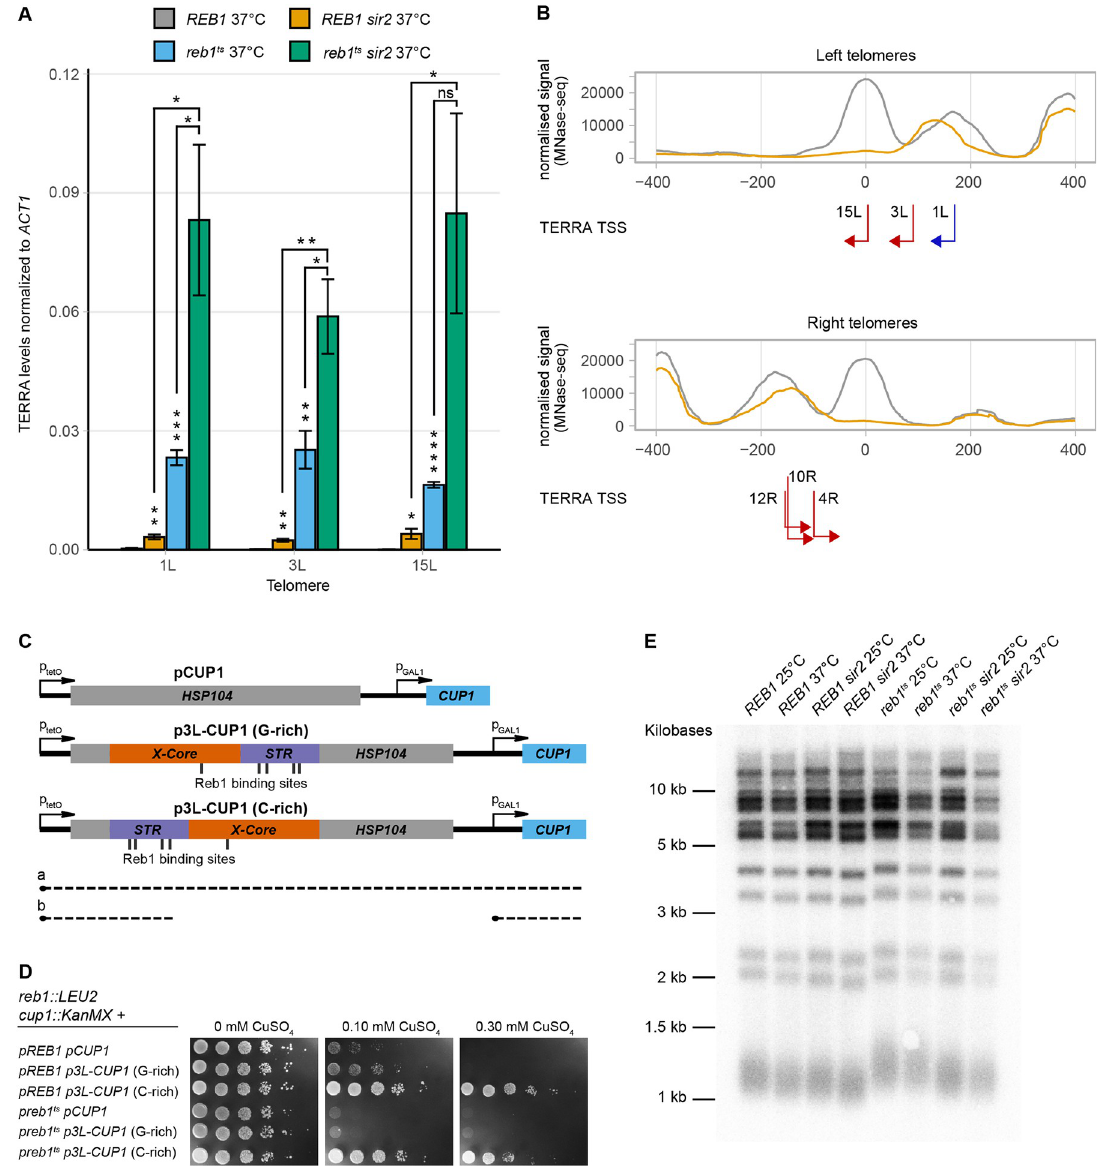
Fig 4. Reb1 regulates TERRAs. ( A ) TERRA RT-qPCR of WT and sir2 strains dependent on either a WT or temperature-sensitive allele of REB1 on a plasmid. Strains were grown at the restrictive temperature. All data are shown as mean ± SEM (n = 3, � p < 0.05, �� p < 0.01, ��� p < 0.001, ���� p < 0.0001, ns = not significant). ( B ) Meta-X-element as in Fig 3A for left and right telomeres, with each TERRA TSS and their respective direction of transcription indicated by red arrows. Blue arrow depicts the TSS from TEL1L, determined previously. ( C ) Schematic for the Cu 2+ -resistance assay used to investigate transcriptional termination by the TEL3L X-element. Transcriptional read-through (a) will interfere with CUP1 transcription and lead to Cu 2+ -sensitivity. Roadblock transcriptional termination (b) will enable CUP1 transcription and confer resistance. ( D ) Cu 2+ -resistance assay. The indicated strains containing either empty vector ( pCUP1 ) or the X-element ( p3L-CUP1 ) in two different orientations spotted in ten-fold serial dilutions on SC plates lacking histidine and containing different concentrations of CuSO 4 , as indicated. Cells were grown at 30˚C, which allowed normal growth of the reb1 Ts strain (left). ( E ) DNA blot analysis of telomere length for the indicated genotypes and temperatures. Xho I digested genomic DNA was probed with a telomeric repeat specific 32 P-end labeled